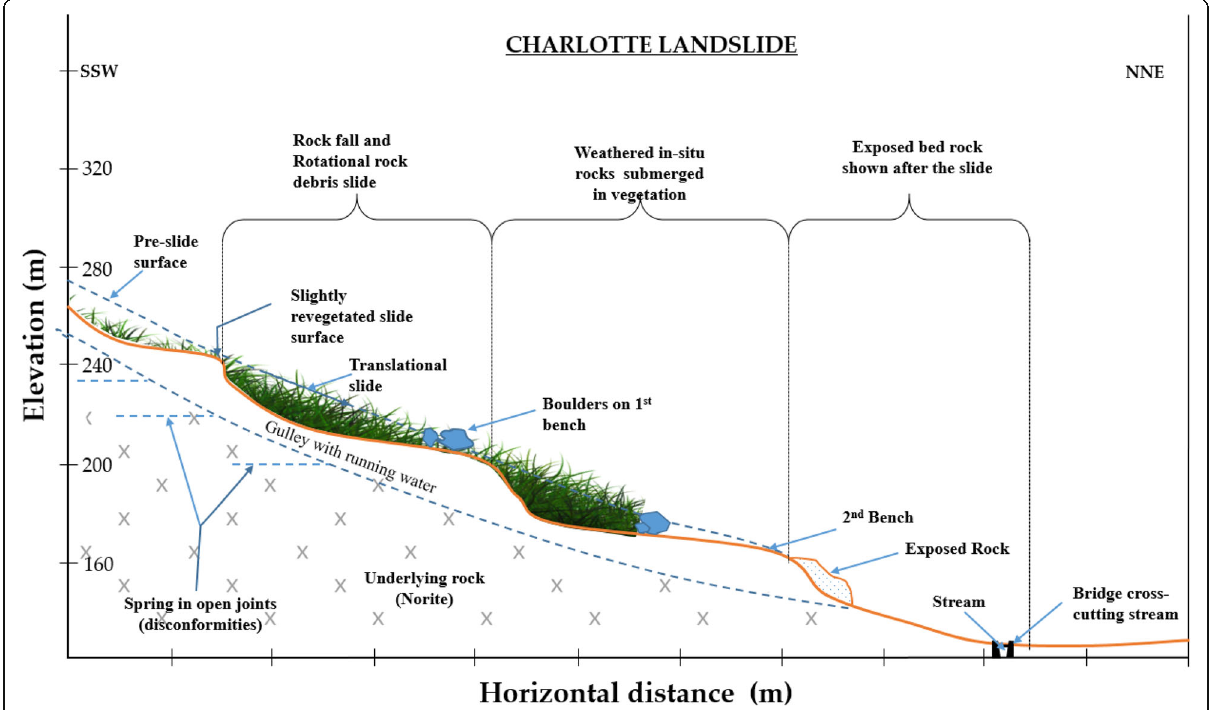
Fig. 11 Schematic section showing the morphology, lithology and tectonic indicators of Charlotte